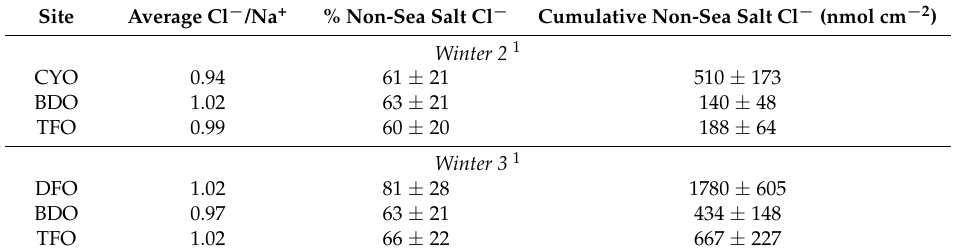
Table 2. Average sample Cl − /Na + ratio, average sample % non-sea salt Cl − , and cumulative non-sea salt Cl − .